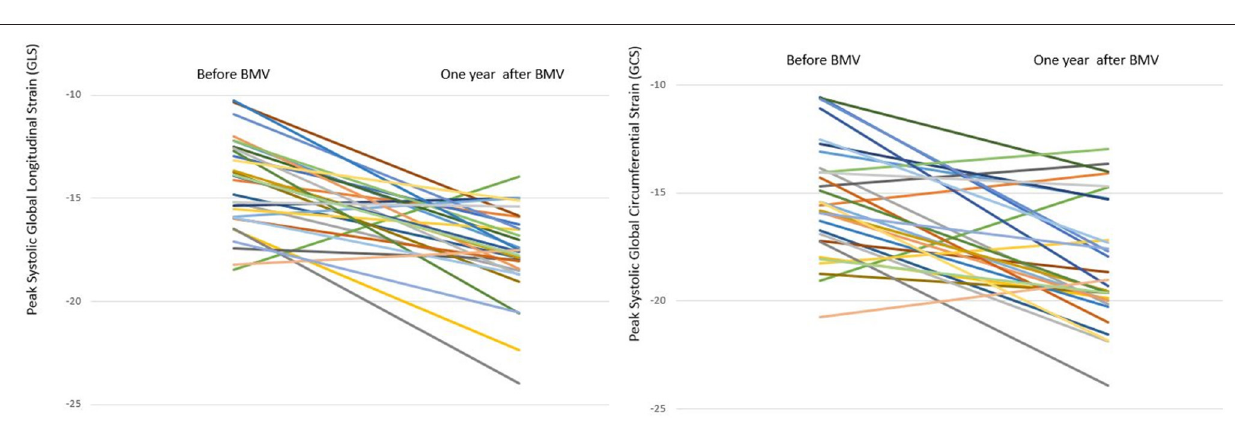
FIGURE 5 | Line chart representing changes in GLS and GCS in individual mitral stenosis patients 1 year after